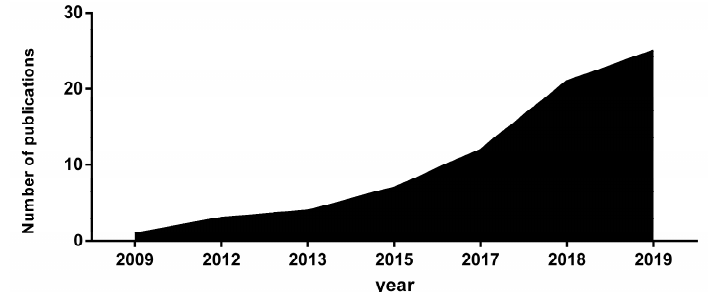
Figure 5. Accumulated publications.